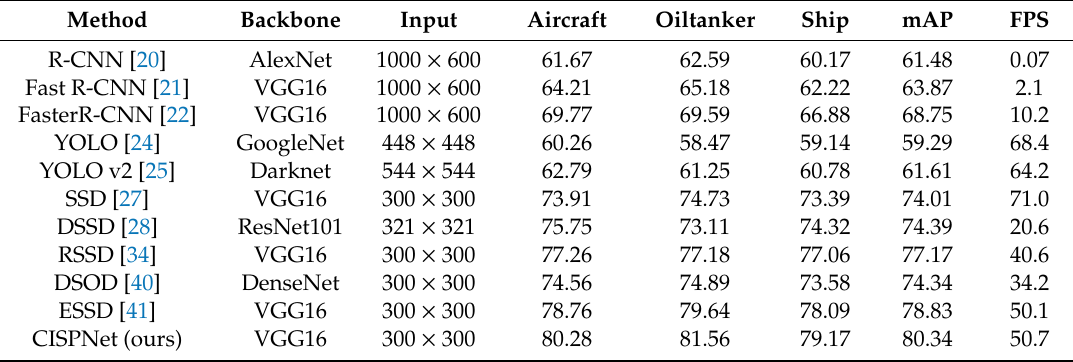
Table 2. Comparisons of speed and accuracy based on remote sensing image dataset tests. (For fair comparison, as introduced in Section 3, we have improved on the basis of SSD and only improved the network structure and the size of the default